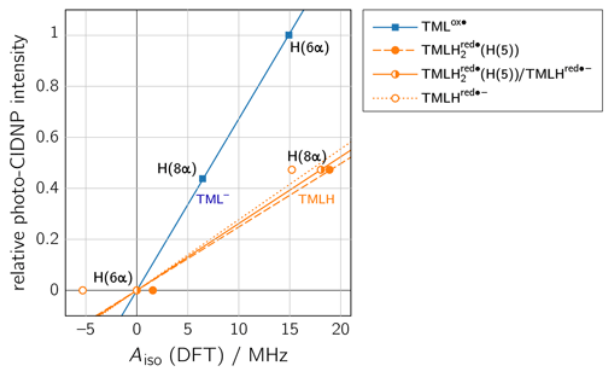
Figure 5. Correlations of relative photo-CIDNP intensities to pre- (cid:113) dicted A iso values from DFT. TML ox : slope = 0.0672MHz − 1 , (cid:113) − : slope = 0.0277MHz − 1 , R 2 = 0.7827; R 2 = 0.9996; TMLH red (cid:113) TMLH red (H(5)): slope = 0.0248MHz − 1 , R 2 = 0.9863; linear 2 (cid:113) (cid:113) − with a ratio of (H(5)) and TMLH red combination of TMLH red 2 0.772:0.228: slope = 0.0262MHz − 1 , R 2 = 1. CIDNP intensities were multiplied by the respective sgn( (cid:49)g